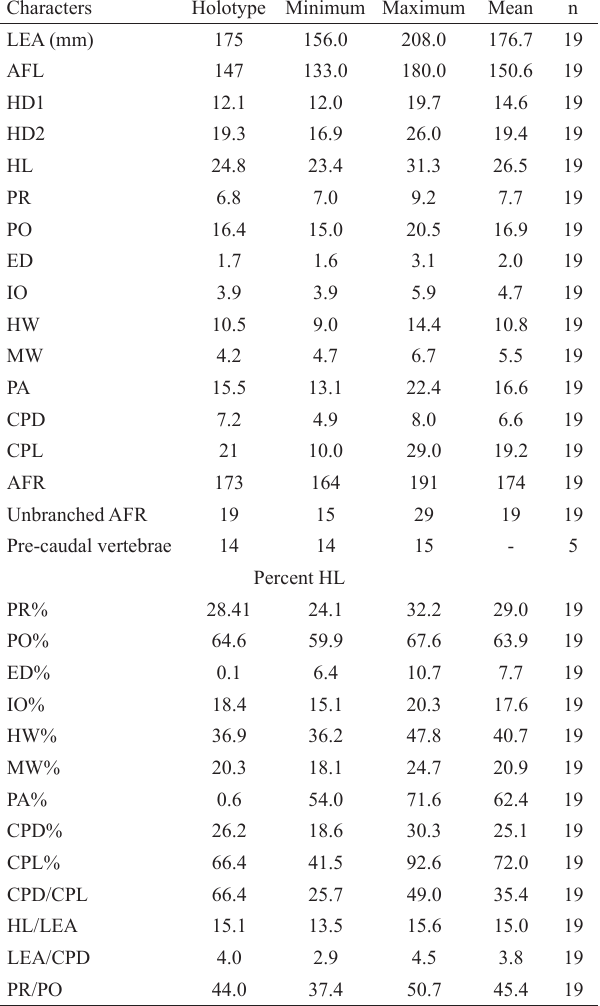
Tab. 2. Morphometrics and meristic measurements for Sternarchella patriciae . Ranges include